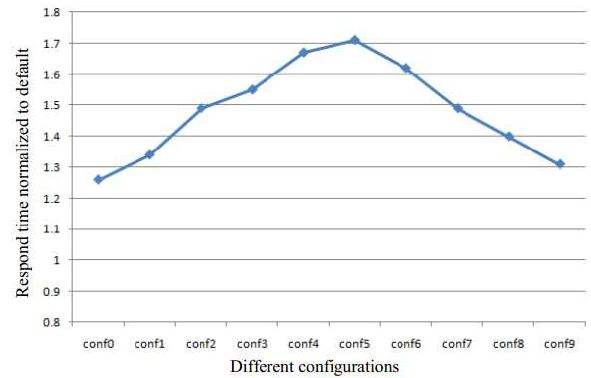
Figure 2. The response time normalized to default from conf0 to